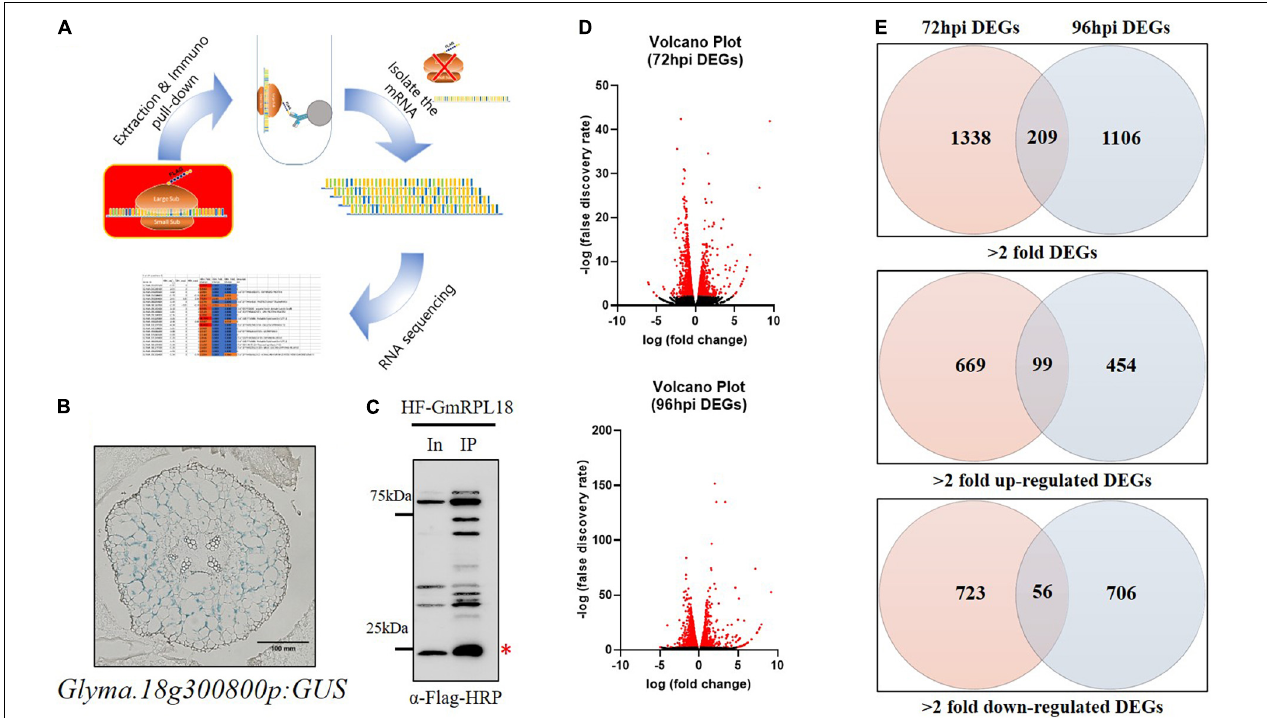
FIGURE 1 | Analysis of genome-wide expressional changes in response to Bj infection in the cortex layer using TRAP-seq. (A) Principles of the TRAP method. Transgenic hairy roots expressing HF-GmRPL18 protein were used for further protein extraction and immunoprecipitation, followed by mRNA isolation and sequencing. (B) Cortex-specific expression of Glyma.18g300800 in uninoculated soybean transgenic hairy root expressing a promoter-GUS construct. (C) Western blot analysis with total and immunoprecipitated proteins. Immuno-pulldown was performed using Anti-FLAG conjugated bead and then protein was detected by anti-FLAG-HRP (Red asterisk indicates the HF-GmRPL18 protein, In: Input protein, IP: Immunoprecipitated protein) (D) volcano plots represent DEGs with significant expressional changes (red) separated by expressional change (log2FC) vs. false discovery rate (-log10). (E) Venn diagrams of up-regulated or down-regulated DEGs (Cutoff: ≥ 2 = fold change for each up-regulated and down-regulated DEGs; p ≤ 0.05).